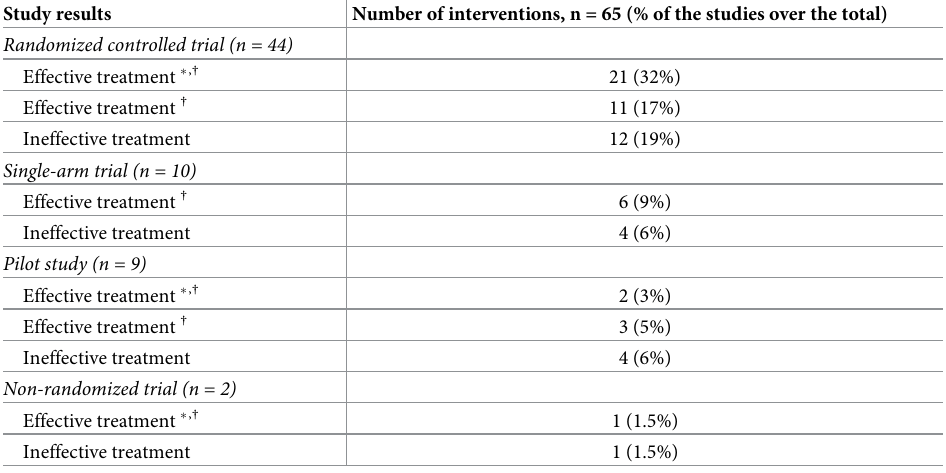
Table 6. Efficacy of self-managed PA protocols (smPA) in reducing CRF compared to the control treatment (when available) and the baseline values. Results are reported and split by study design. Both raw data and percent- ages computed over the total (n = 65) are presented.